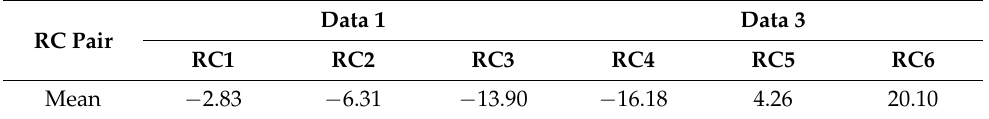
Table 4. The mean of theoretical ISB